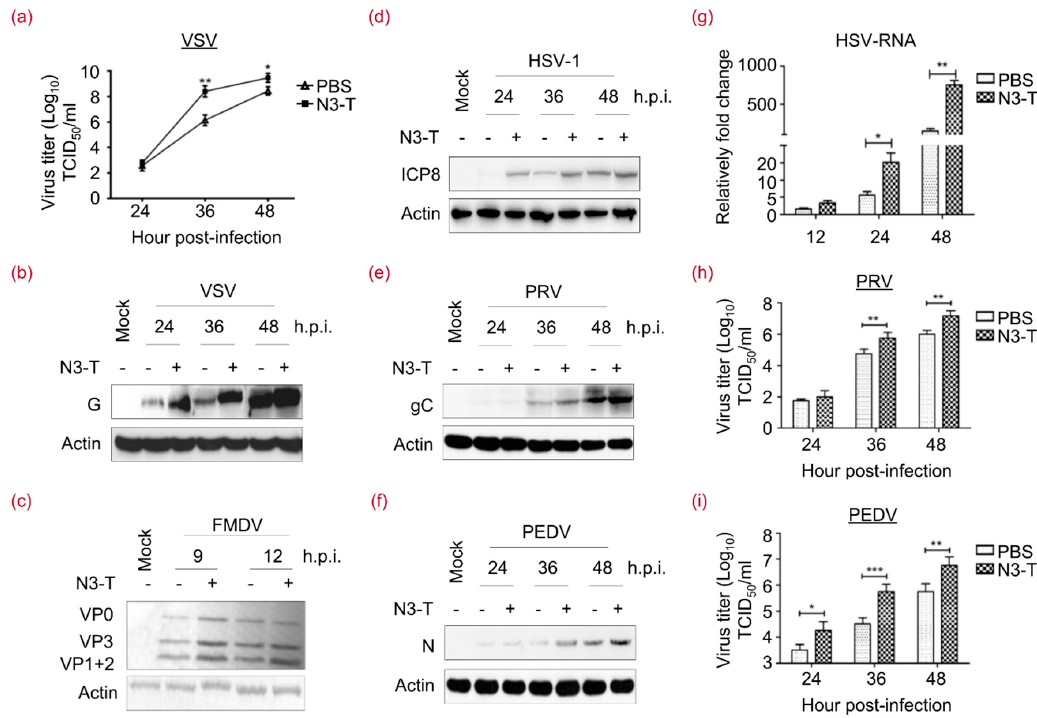
Figure 7. N3-T promotes viral replication in a time-dependent manner. ( a ) HEK293T cells were infected with VSV at 0.1 MOI in the presence of PBS or N3-T (20 µg/mL), and viral yields were determined as TCID 50 /mL at 36, 48, or 60 h. These experiments were performed twice with three replicates in each experiment. Values represent means with SD. * p < 0.05; ** p < 0.01; ( b ) HEK293T cells in T-25 flask were infected with VSV at 0.01 MOI in the presence of PBS or N3-T (20 µg/mL) for the indicated times. Cell lysates were analyzed by immunoblotting with antibodies against VSV-G. Actin served as the loading control; ( c ) PK-15 cells in T-25 flasks were infected with FMDV at 10 TCID 50 in the presence of PBS or N3-T (20 µg/mL) for 9 or 12 h. Cell lysates were analyzed by immunoblotting with polyclonal pig antiserum against FMDV and actin. Shown is one representative of two independent experiments; ( d ) HeLa cells were exposed to HSV-1 at 0.01 MOI in the presence of PBS or N3-T (20 µg/mL) for 24, 36, or 48 h. Cell lysates were analyzed by immunoblotting with antibodies against HSV-ICP8 and actin. Shown is one representative of two independent experiments; ( e , f ) Vero cells were exposed to PRV ( e ) or PEDV ( f ) at 0.01 MOI in the presence of PBS or N3-T (20 µg/mL) for 24, 36, or 48 h. Cell lysates were analyzed by immunoblotting with antibodies against PRV-gC or PEDV-N, and actin. Shown is one representative of two independent experiments; ( g ) HeLa cells were exposed to HSV-1 at 0.01 MOI in the presence of PBS or N3-T (20 µg/mL) for the indicated times. Total RNAs were isolated and gene expression levels of HSV-ICP8 were quantified by RT-PCR and normalized to that of GAPDH. These experiments were performed twice with three replicates in each experiment. Values represent means of triplicates with SD. * p < 0.05, ** p < 0.01; ( h , i ) Vero cells were exposed to PRV ( h ) or PEDV ( i ) at 10 TCID 50 in the presence of PBS or N3-T (20 µg/mL) for 24, 36, or 48 h. Virus titer was presented as log 10 TCID 50 /mL. These experiments were performed twice with three replicates in each experiment. Values represent means of triplicates with SD. * p < 0.05, ** p < 0.01, *** p < 0.001.